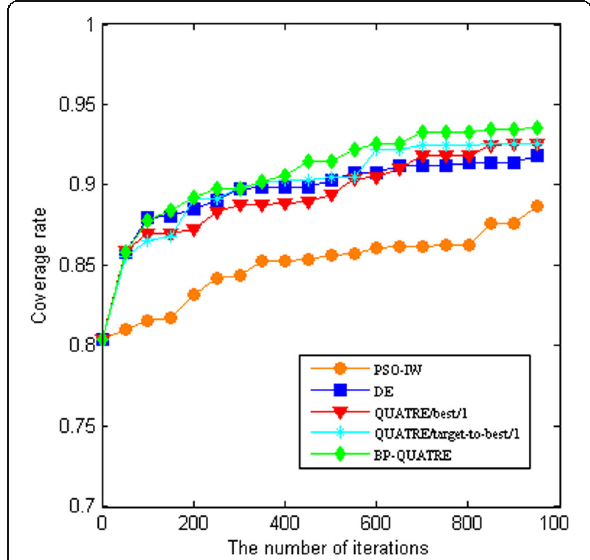
Fig. 4 Comparison of coverage rates of the proposed algorithm with the other algorithms, e.g., PSO-IW, DE, QUATRE/best/1 and QUATRE/targetto-best/1